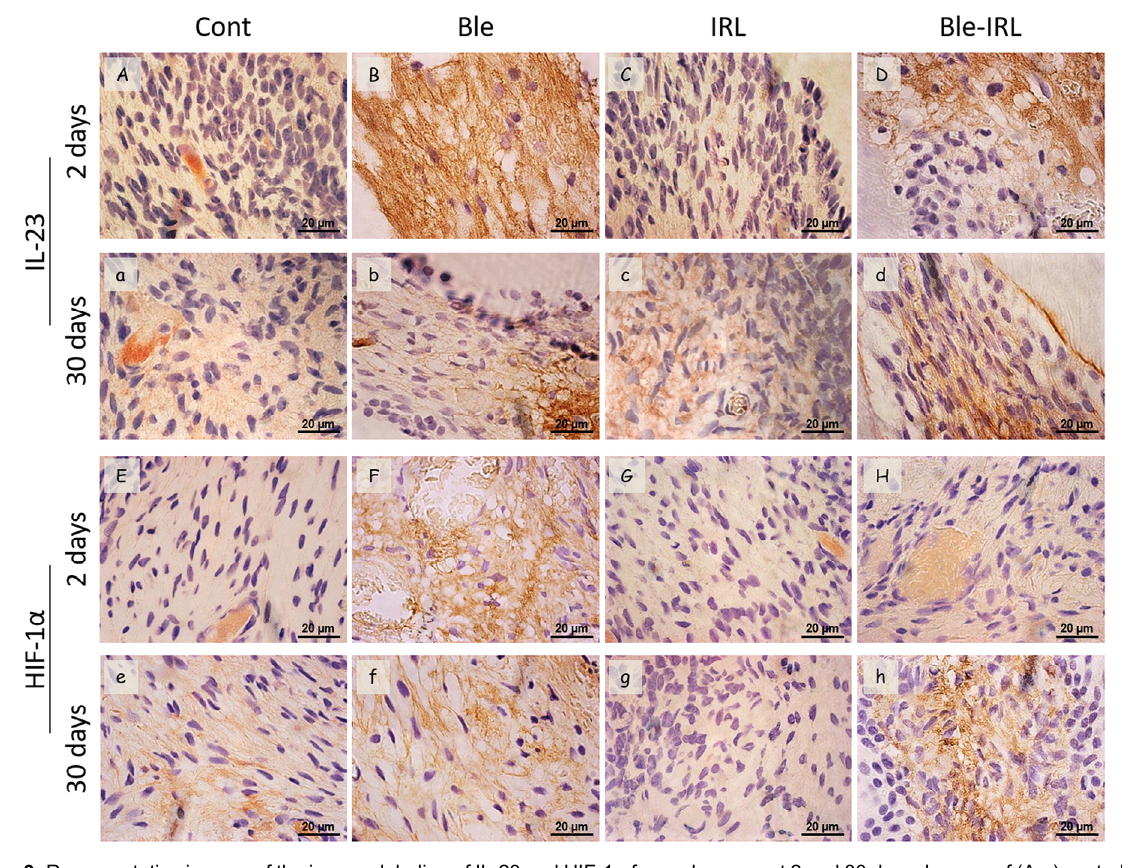
Figure 3- Representative images of the immunolabeling of IL-23 and HIF-1 α for each group, at 2 and 30 days. Images of (A,a) control and (C,c) IRL groups with absence of IL-23 immunolabeling at (A, C) 2 and (a, c) 30 days; (B,b) Bleached group with severe and moderate immunolabeling at (B) 2 and (b) 30 days, respectively; and (D,d) Bleached-IRL group with moderate and mild immunolabeling at (D) 2 and (d) 30 days, respectively. Images of (E,e) control and (G,g) IRL groups with absence of HIF-1 α immunolabeling at (E, G) 2 and (e, g) 30 days; (F,f) Bleached group with moderate and mild immunolabeling at (F) 2 and (f) 30 days, respectively; and (H,h) Bleached-IRL group with mild and moderate immunolabeling at (H) 2 and (h) 30 days, respectively. [1000×;